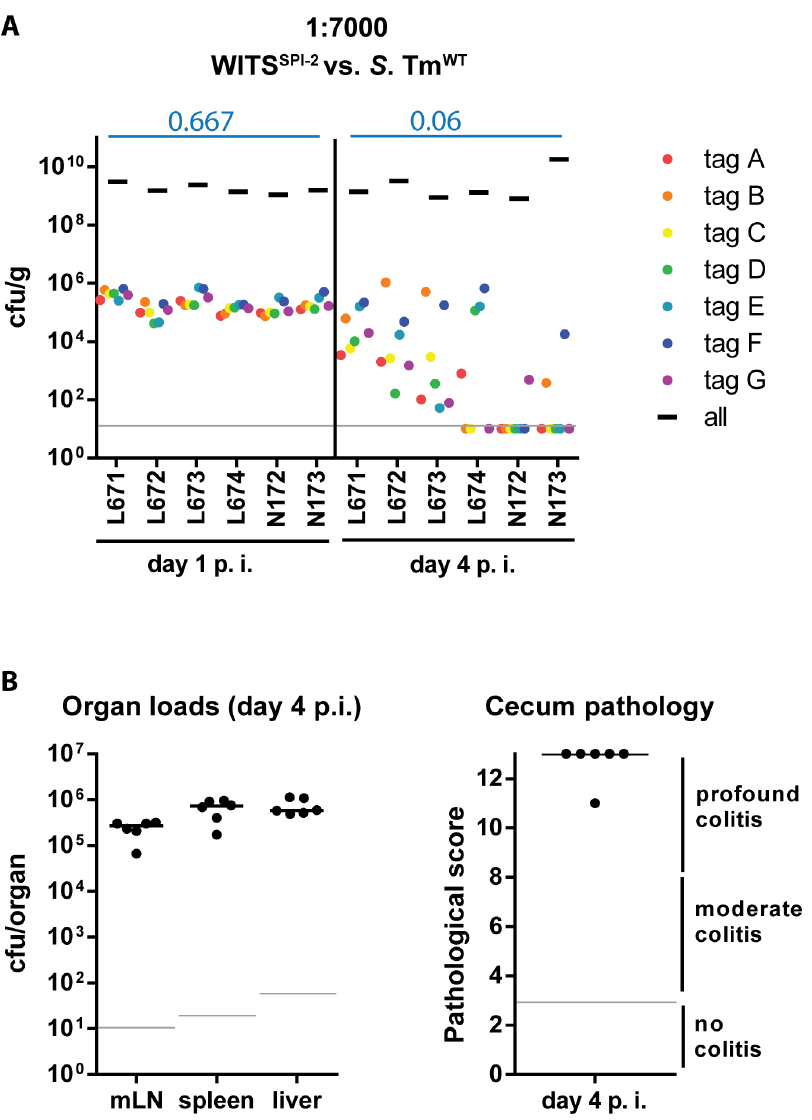
Fig. 4. Severity of inflammation, not genetic background of the tagged strains, determines WITS diversity loss. (A) To exclude a strain- intrinsic property of the SPI-2 WITS to be responsible for the decrease in WITS diversity loss observed in the S. Tm SPI-2 background, we tested a chimeric situation in which inflammation was caused by S. Tm WT but WITS-tags were in a SPI-2 deficient background. Experiments were performed using a WITS cocktail in a dilution of 1:7000. Grey lines depict the detection limit for plating (10 cfu/g). Blue numbers indicate the median of the evenness indices of single mice. (B) Organ loads and cecum pathology at day 4 p.i. confirmed the ‘‘WT-like’’ severity of the infection.